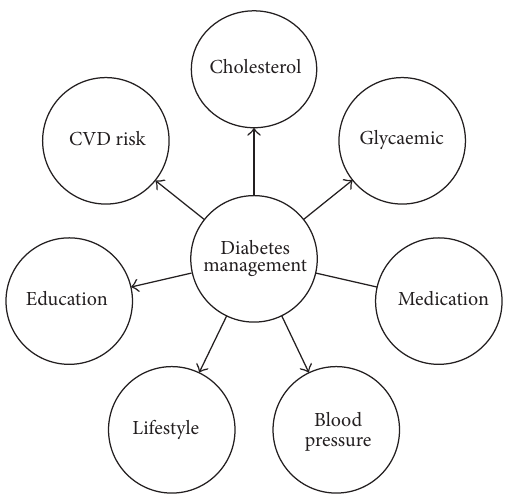
Figure 1: Summary of the seven evidence-based factors required in diabetes